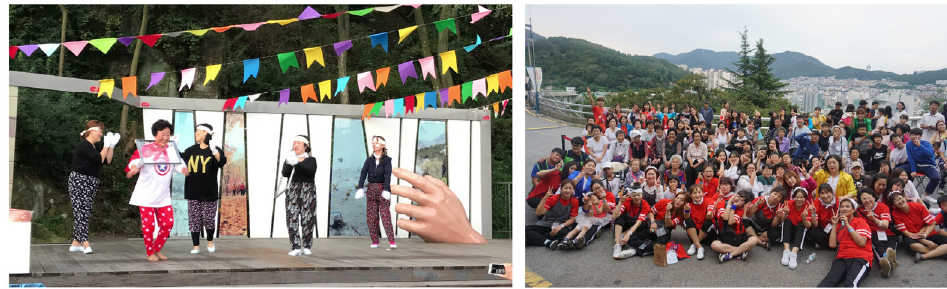
Figure 12. Let’s Hangout in Ami-dong event (2014).